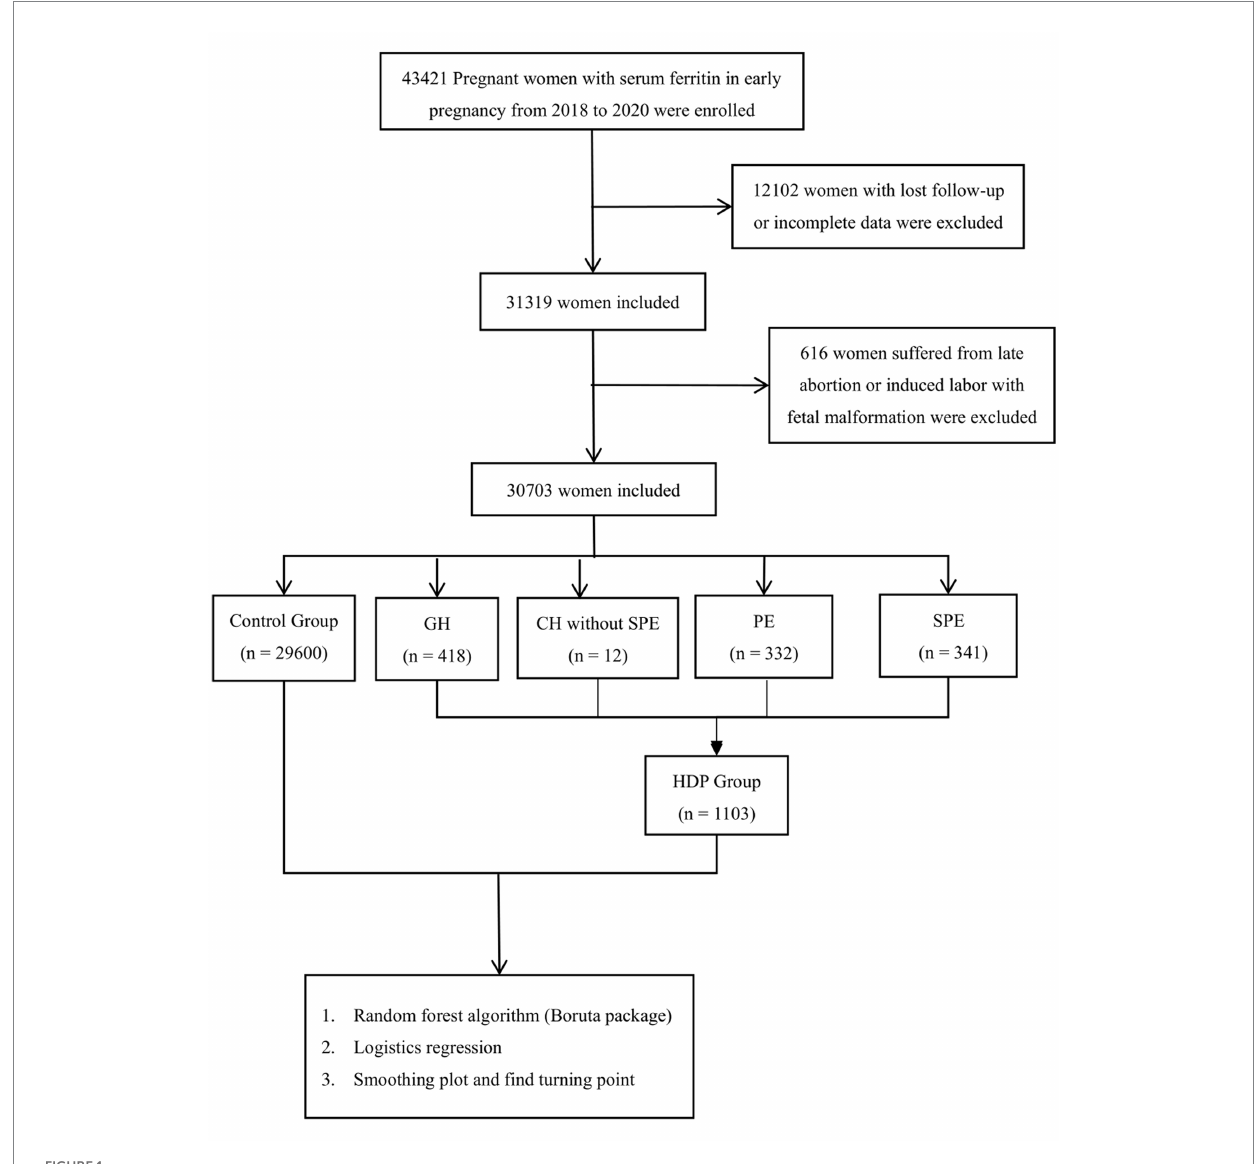
FIGURE 1 Flowchart of the enrolled pregnancy